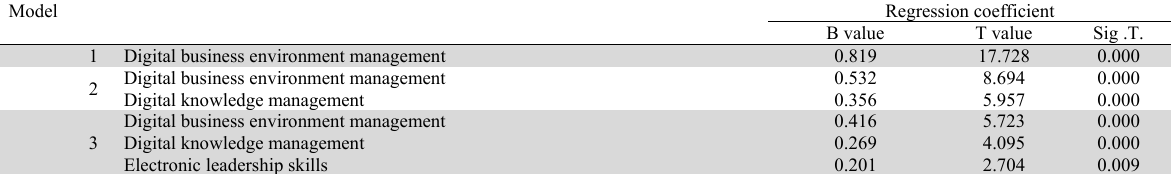
The stepwise multiple linear regression analysis for exploring the impact of digital entrepreneurship dimensions jointly